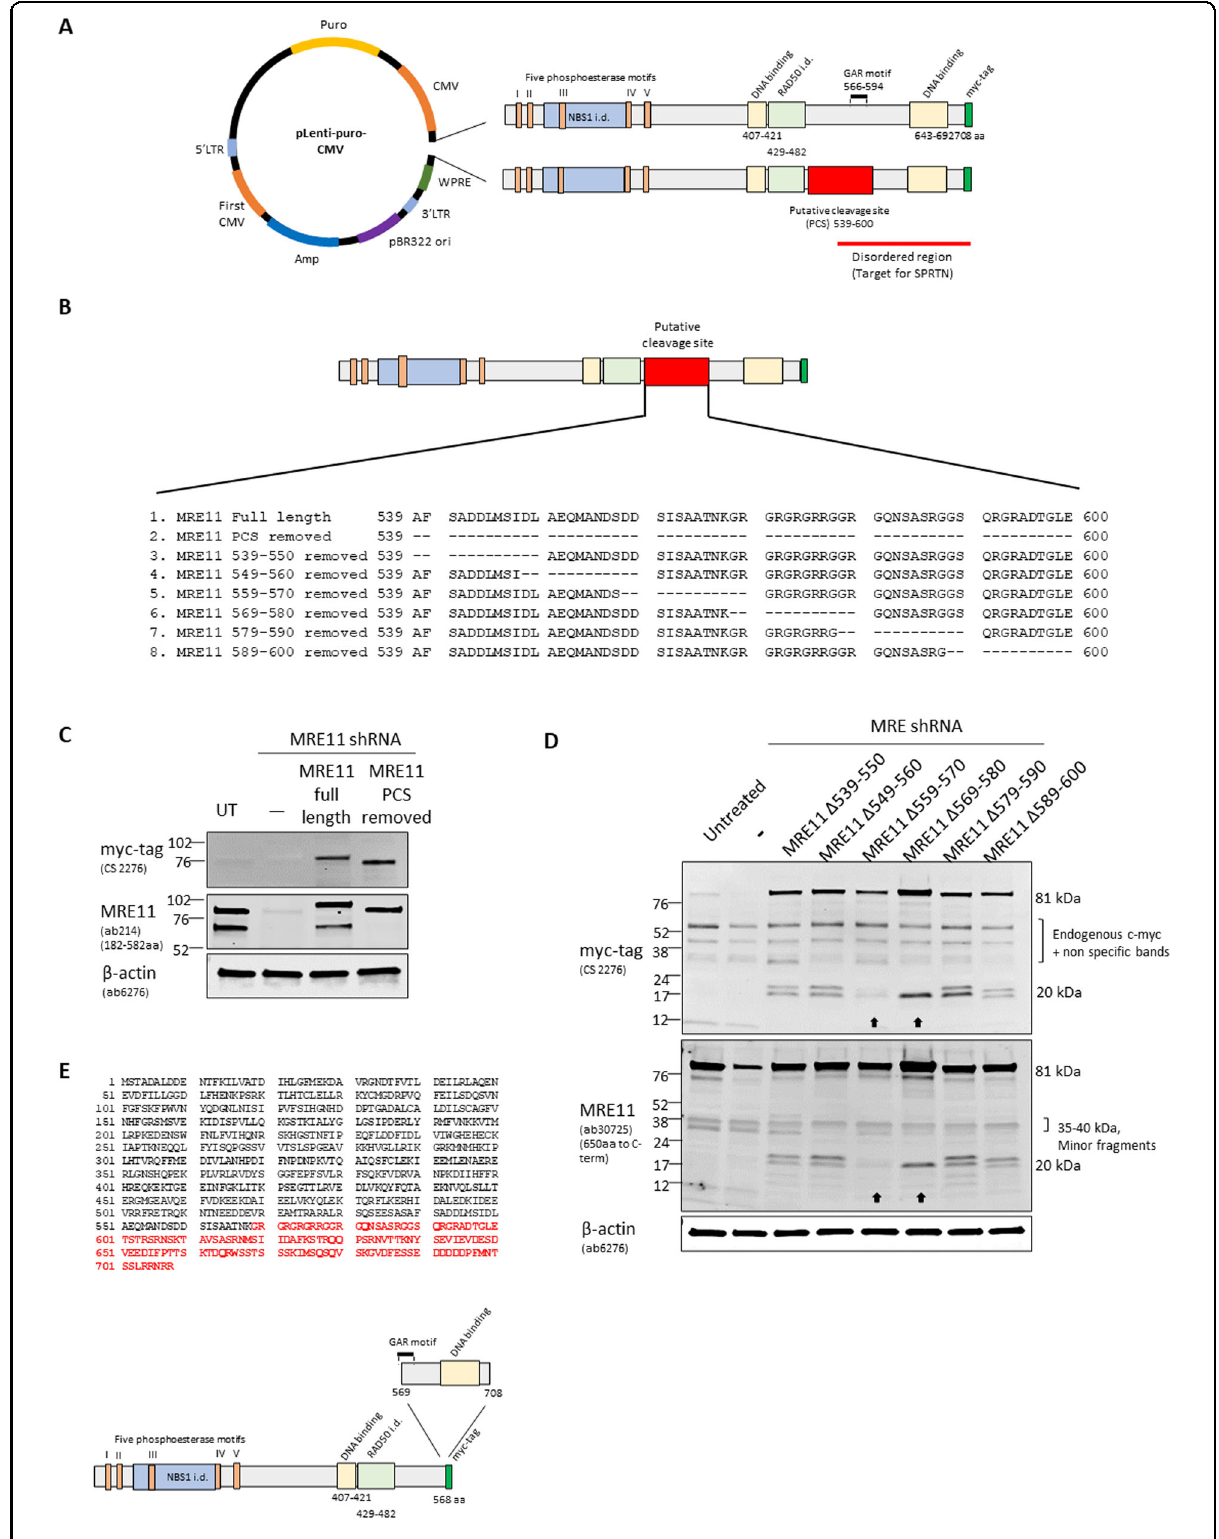
Fig. 2 (See legend on next